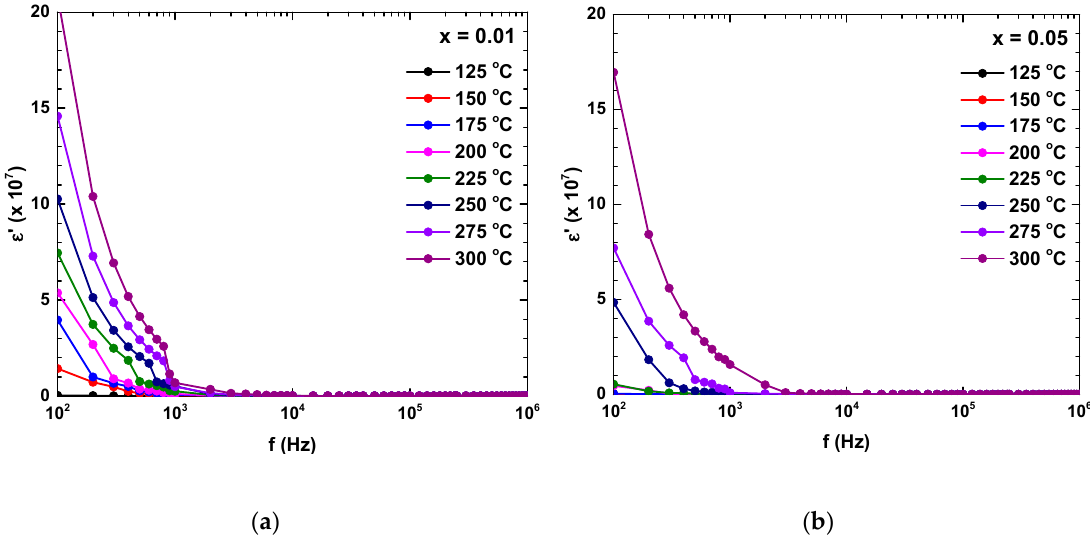
Figure 7. Dielectric constant, ε (cid:48) (f), of LaFe 1 − x Zr x O 3 with ( a ) x = 0.01 and ( b ) x = 0.05 annealed at 800 ◦ C for 6 h at different temperatures.